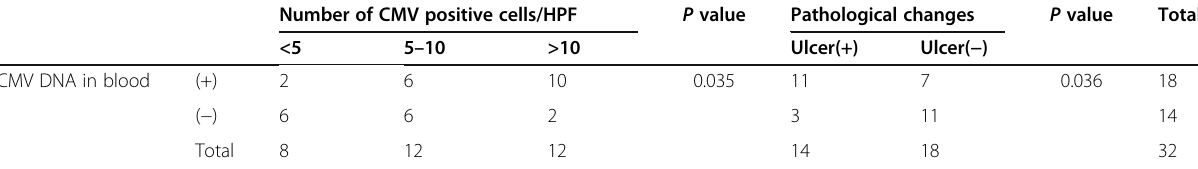
Table 3 Clinicopathological correlation of gastrointestinal tract CMV infection Number of CMV positive cells/HPF P value Pathological